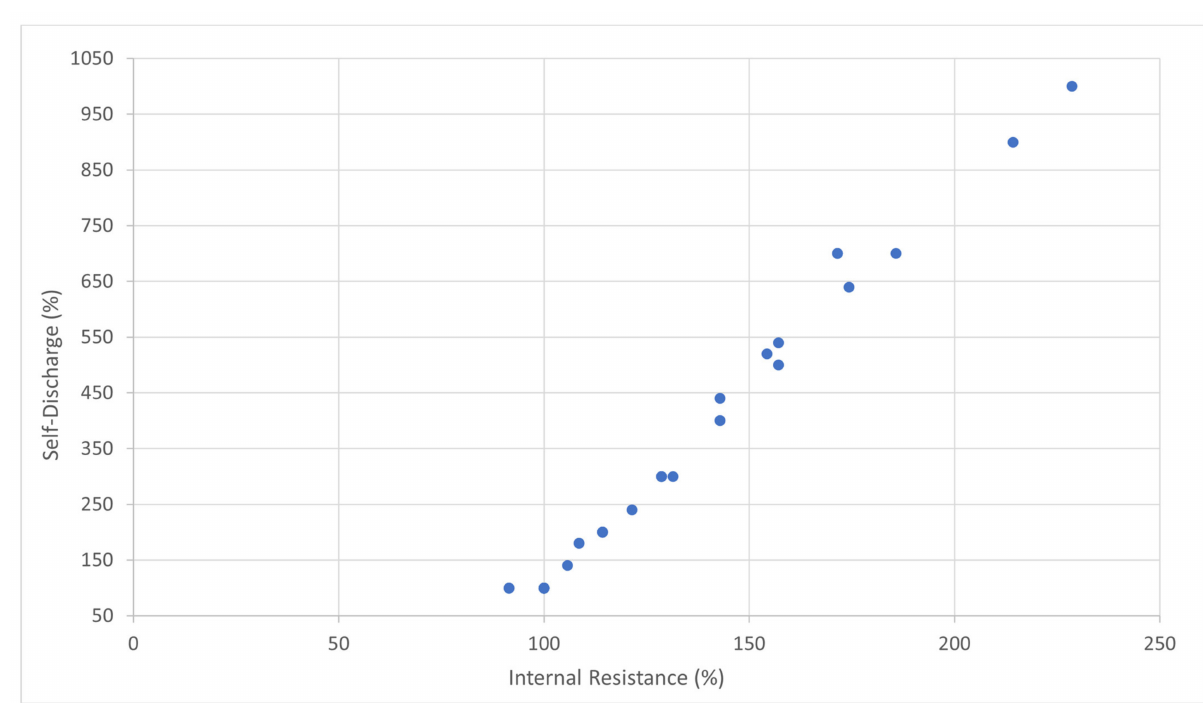
Figure 4. Relaxation voltage drop evolution.